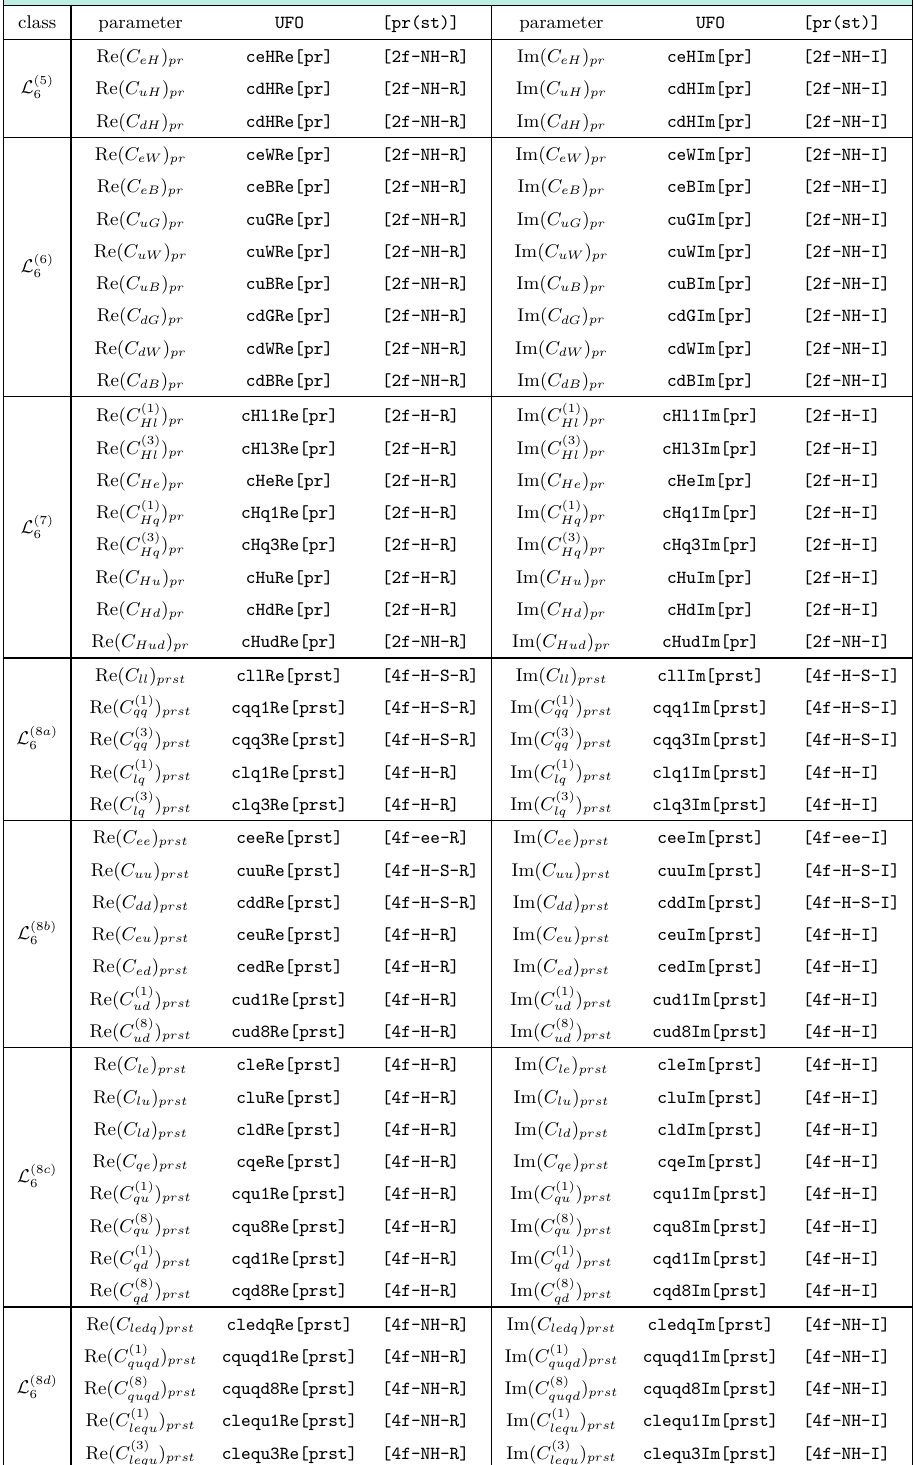
defined in the general flavor model, see 6